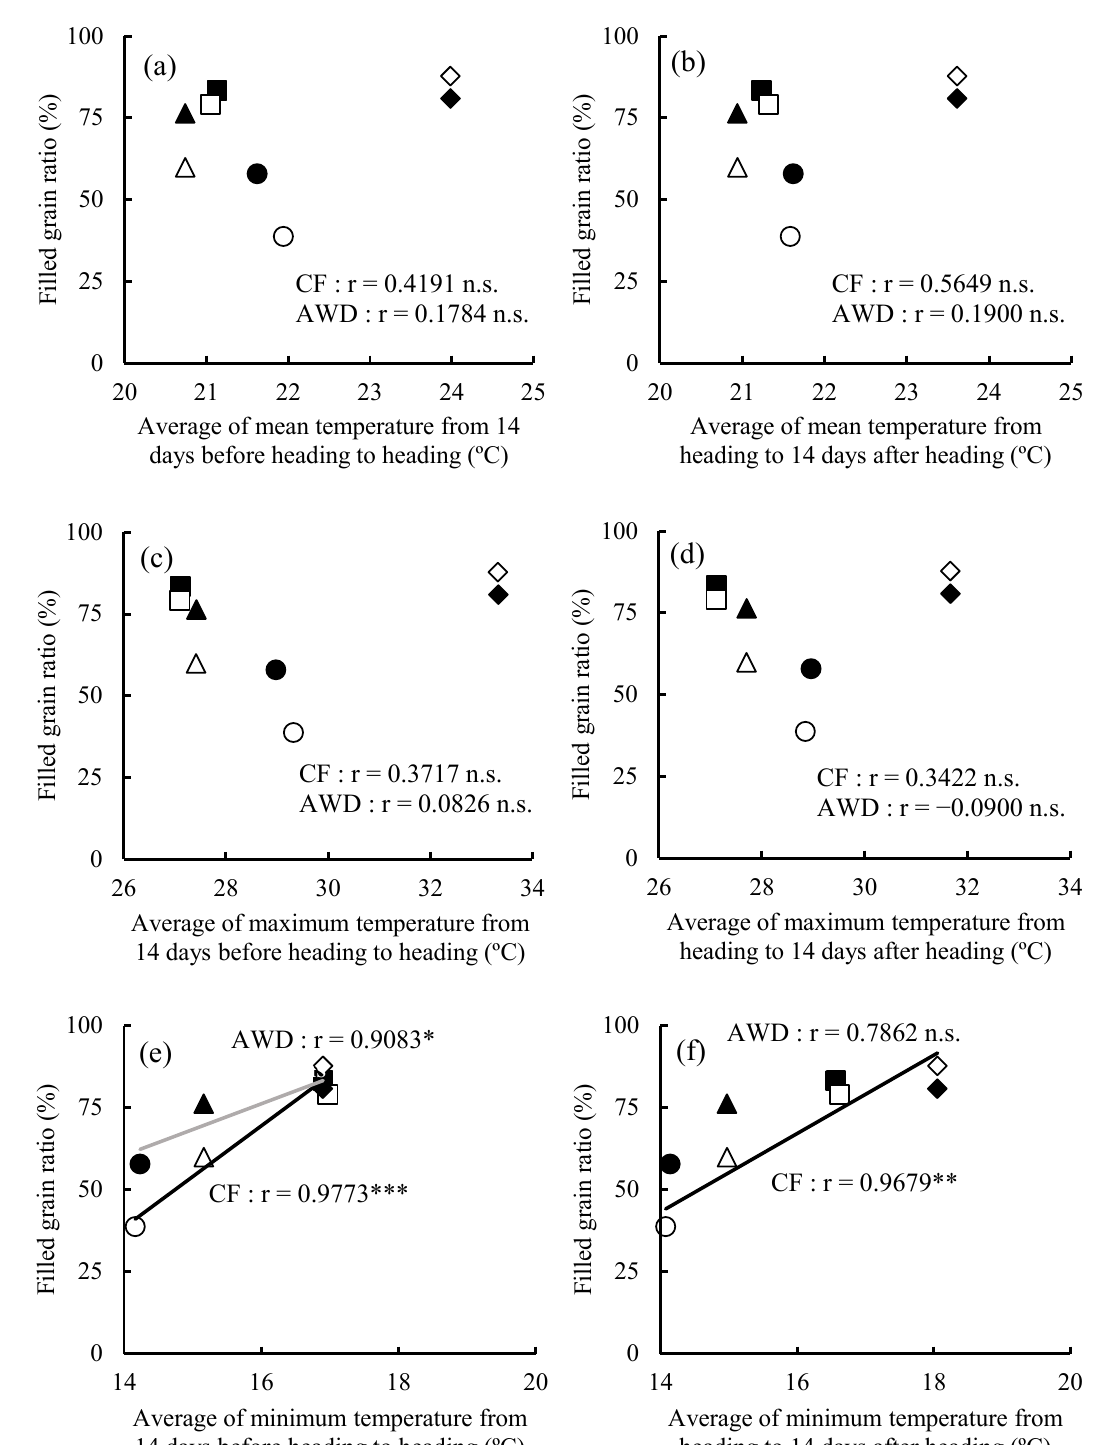
), 2015 ( (cid:4) , (cid:3) ), 2016 ( (cid:78) , (cid:52) ), (cid:35)